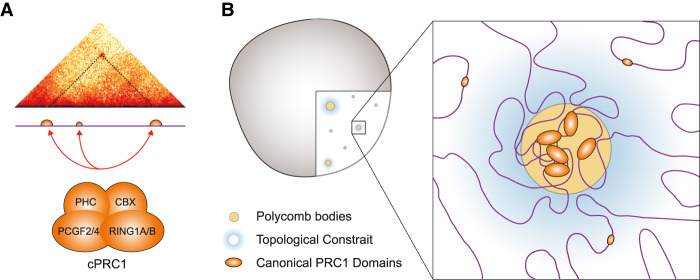
Canonical PRC1 influences gross nuclear organization. (A) PcG mediated interactions occur preferentially between sites with the most pronounced and extended domains of canonical PRC1 occupancy. (B) We propose that PRC1-bound loci cluster together in the nucleus to form discrete polycomb bodies. This clustering, coupled with the polymeric nature of chromatin, imposes topological constraint on intervening non-PcG-associated portion of the genome.